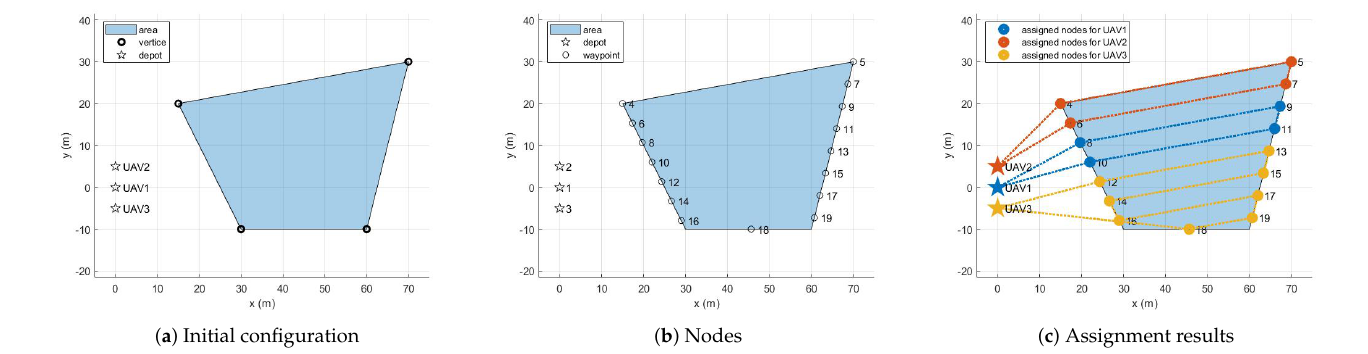
Figure 4. Task assignment procedures for the sample